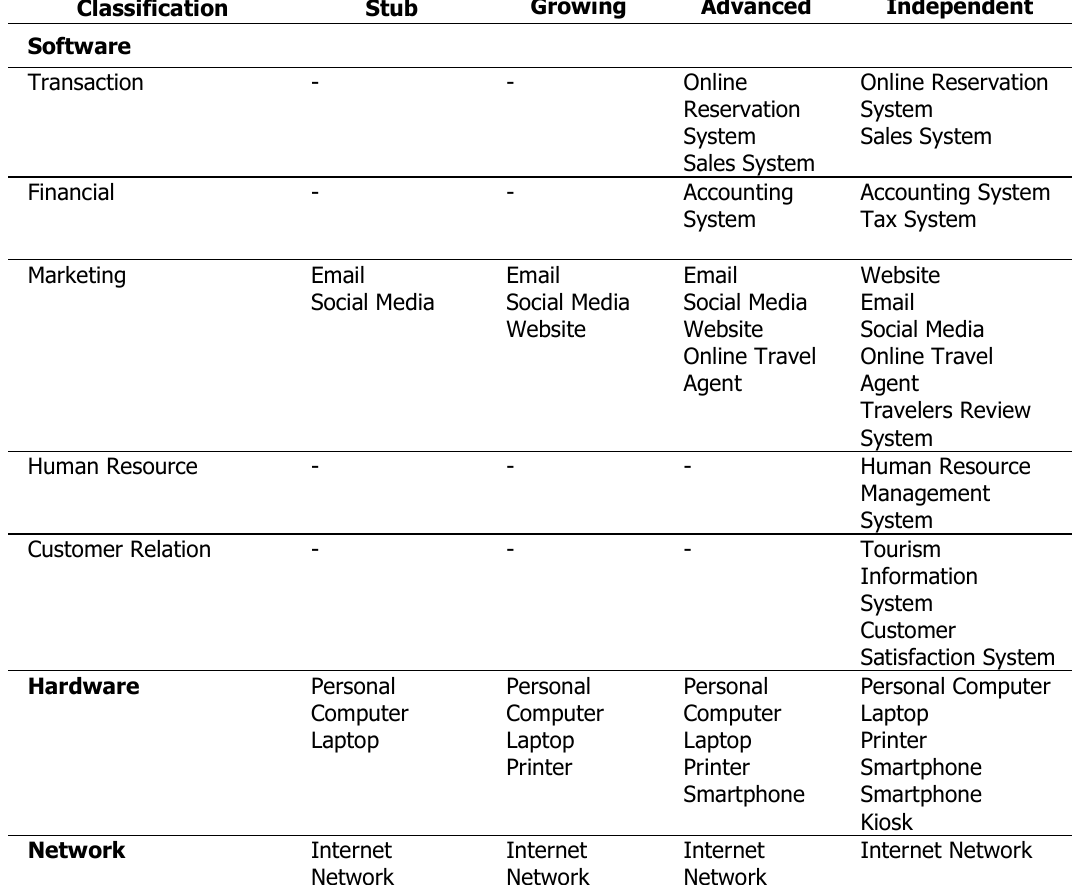
Table 5. Model Application